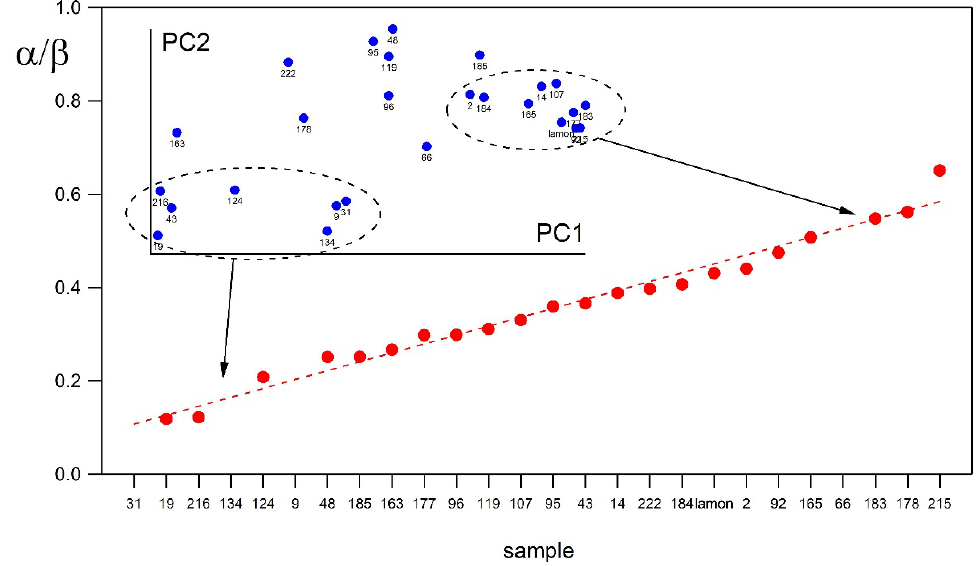
Figure 2. Ratio between percentage of α -helix and β -sheet secondary structures for common bean varieties (red points and dashed line). Dashed line is a guide for the eyes. In the inset the score-plot of PC1 and PC2 obtained from a PCA analysis on fit results is reported. (Carbonaro and Nucara, personal communication).